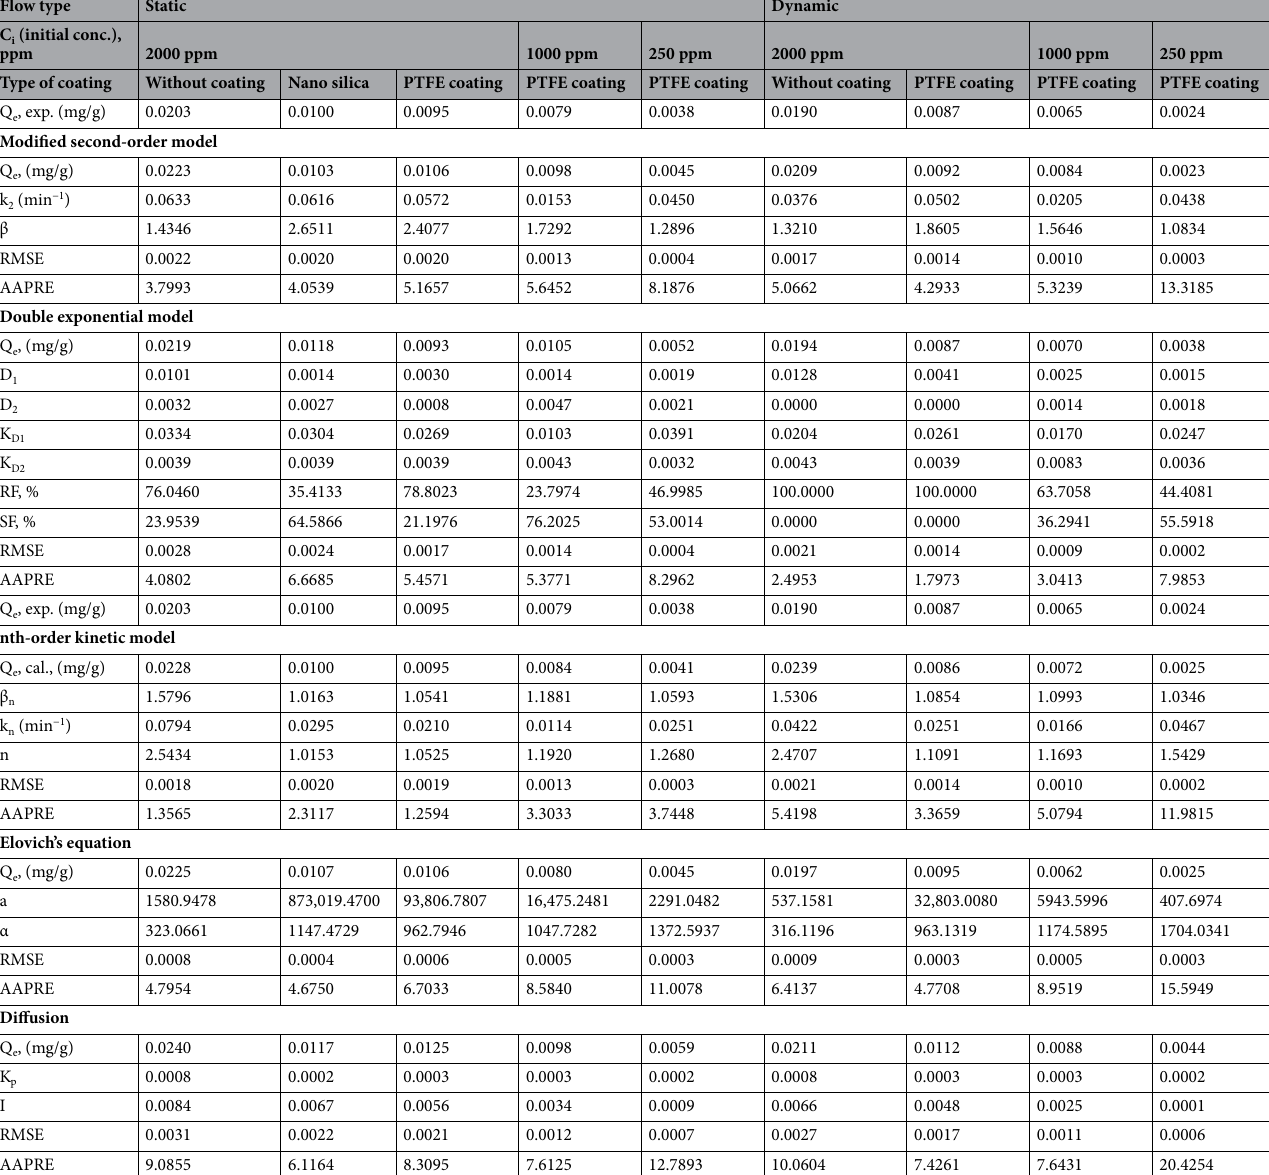
Table 9. Parameters calculated for a variety of kinetic